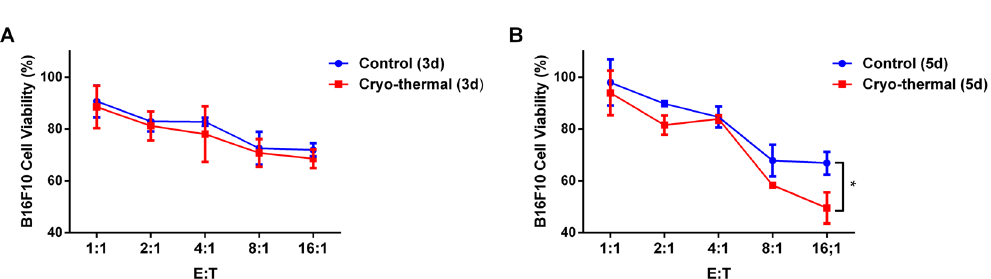
Figure 3. Cryo-thermal therapy enhanced the cytotoxic activity of eosinophils against tumour cells. Cytotoxic potential of eosinophils after cryo-thermal therapy. Splenic Siglec-F + eosinophils in cryo-thermal-treated mice and tumour-bearing mice were purified and co-cultured with B16F10 cells at indicated ratios, and the cell viability (%) of B16F10 cells was determined by a CCK-8 assay. ( A ) The B16F10 cell viability (%) in co-cultured with eosinophils from cryo-thermal-treated mice on day 3 or tumour-bearing mice on day 15 after tumour inoculation. ( B ) The B16F10 cell viability (%) in co-cultured with eosinophils from cryo-thermal-treated mice on day 5 or tumour-bearing mice on day 17 after tumour inoculation. Data was shown as mean ± SD. Data for bar graphs was calculated using student’s t-test. * p <